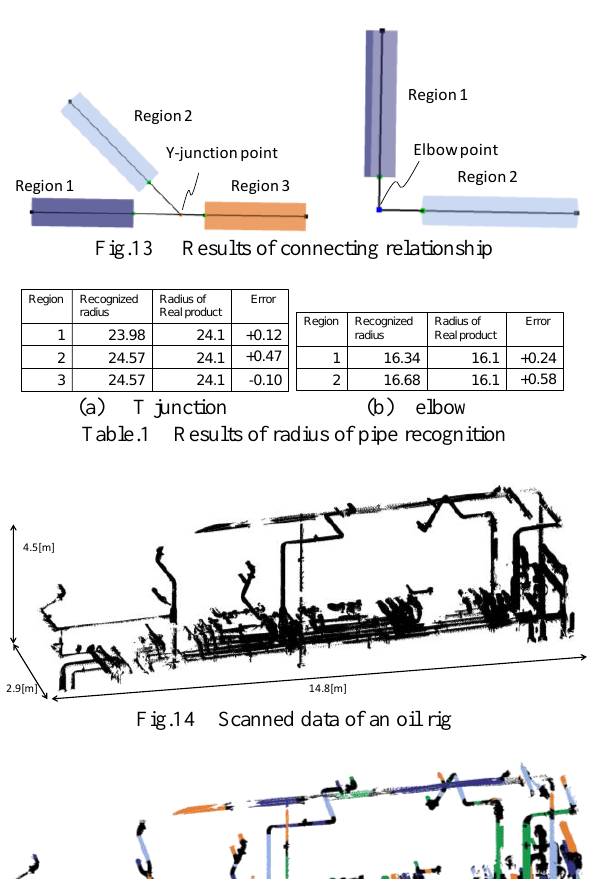
Fig.12 Recognition results of “pipe” points recognition